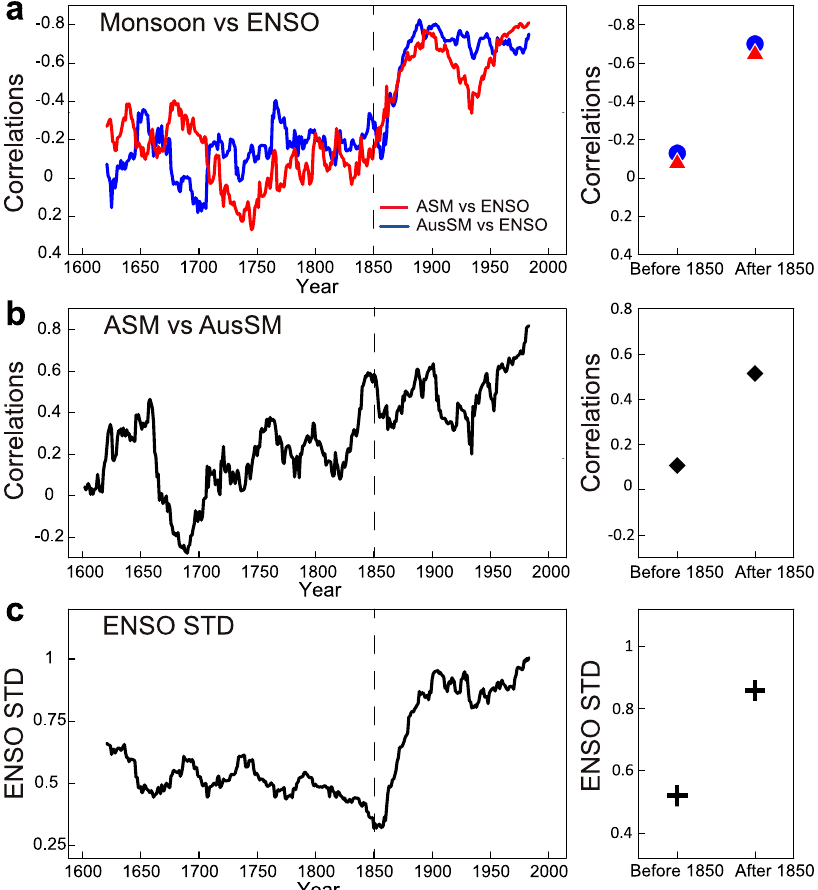
Fig. 3 ASM-AusSM and monsoon-ENSO relationship during the last 400 years. a 31-year running correlations between ASM(red line)/ AusSM(blue line) precipitation and ENSO. b 31-year running correlations between ASM and AusSM precipitation. c 31-year running standard deviation of reconstructed annual ENSO index during the period of 1588 – 1999. Correlation coef fi cients of monsoon-ENSO/inter-monsoon and standard deviation of reconstructed annual ENSO index at the period of 1588 – 1850 and 1851 – 1999 were shown in right